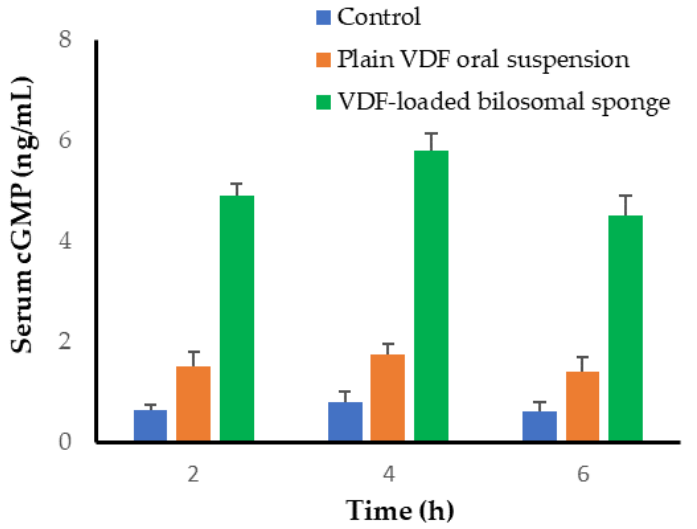
Figure 9. Serum cGMP levels following treatment with VDF-loaded bilosomal buccal sponge and VDF oral suspension. Data represented as mean ± SD.